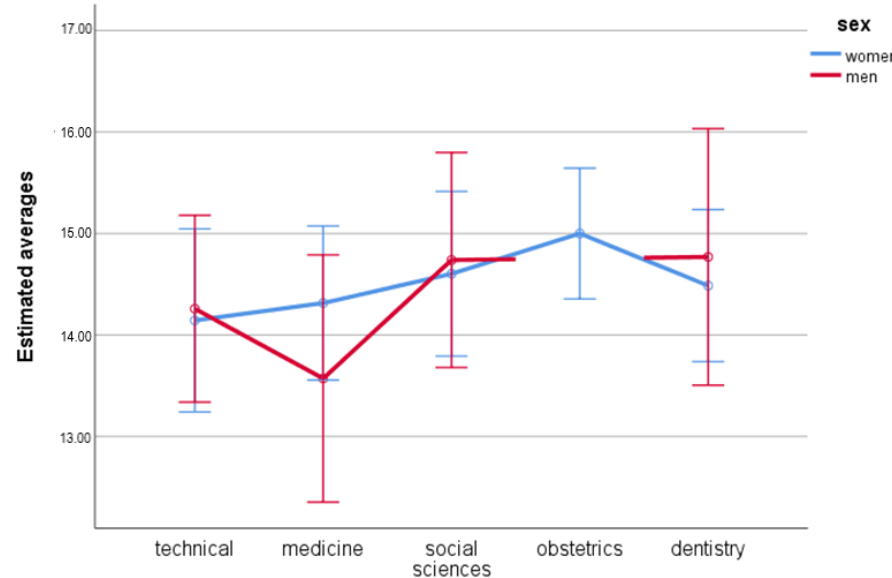
Figure 3. Estimated averages for the third domain with regard to sex and field of study.